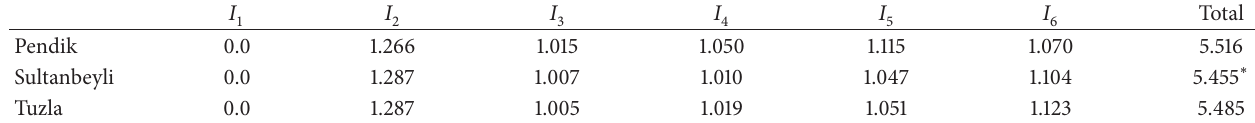
Table 11: Unit Index for weighted information contents for Asian Side of Istanbul.